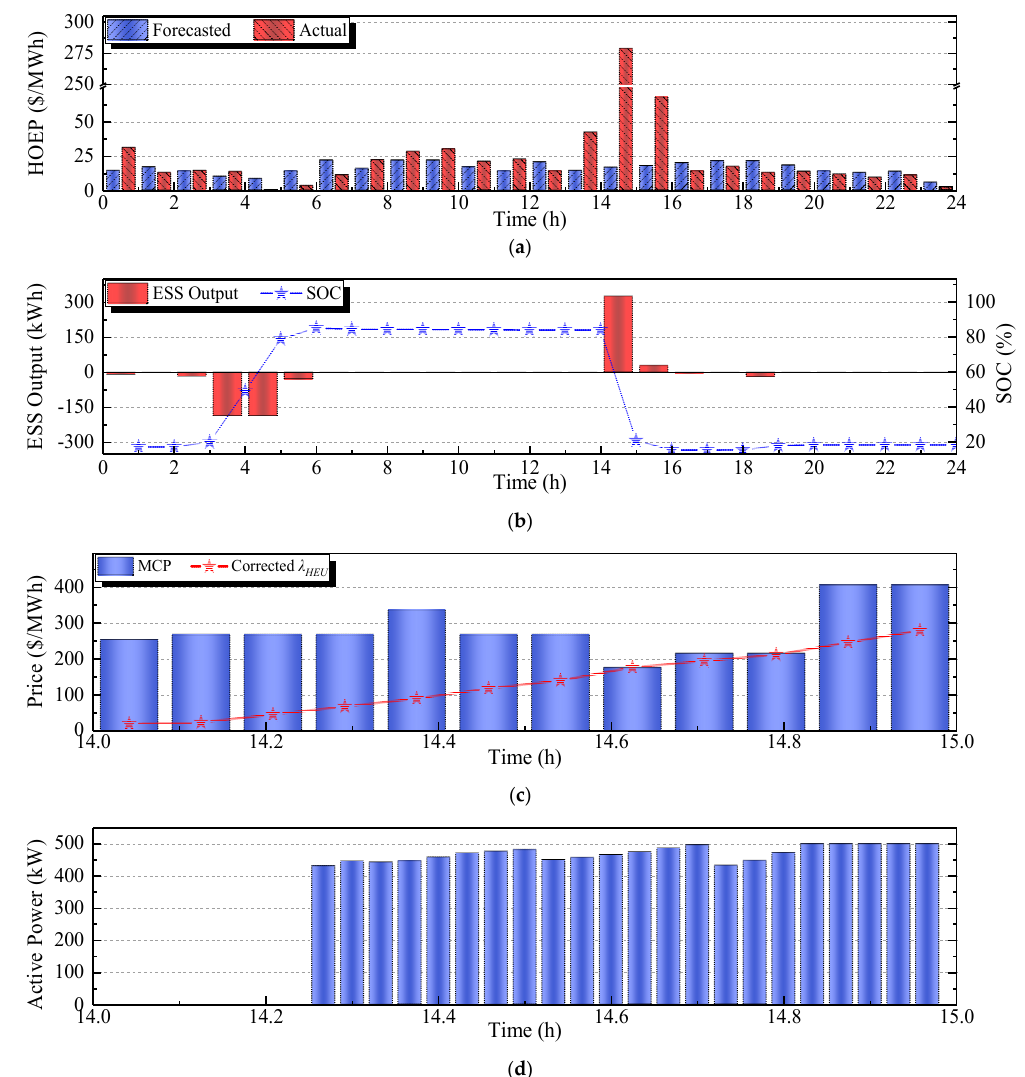
Figure 9. Actual operation results for February 24, 2017: ( a ) Forecasted and actual HOEPs; ( b ) Active power output and SOC of the ESS; ( c ) MPCs between 14 h and 15 h; ( d ) Active power output between 14 h and 15 h.